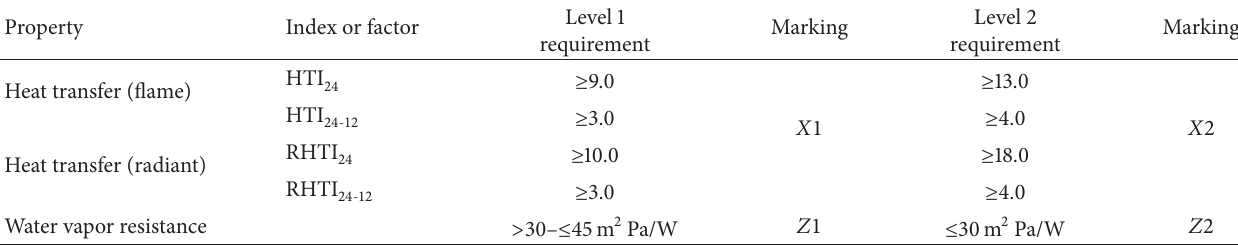
Table 1: Requirement for the heat and moisture transfer property of firefighter turnout clothing in EN469 Standard: 2014. Property Index or factor Level 1 Heat transfer (flame) RHTI 24 ≥ 10.0 ≥ 18.0 Heat transfer (radiant) ≥ 3.0 ≥ 4.0 RHTI 24 - 12 Water vapor resistance > 30– ≤ 45 m 2 Pa/W 𝑍1 ≤ 30 m 2 Pa/W 𝑍2 HTI: Heat Transfer